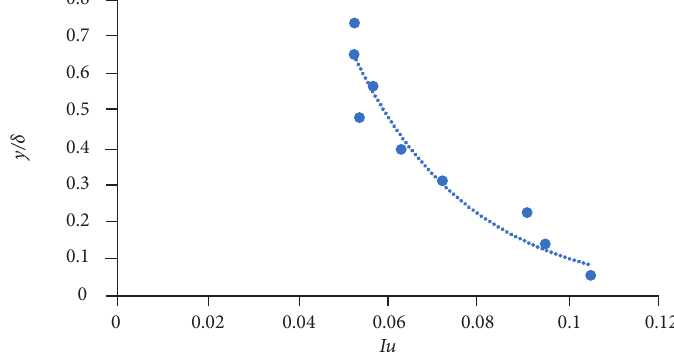
Figure 7. Velocity profile in the middle of test section.